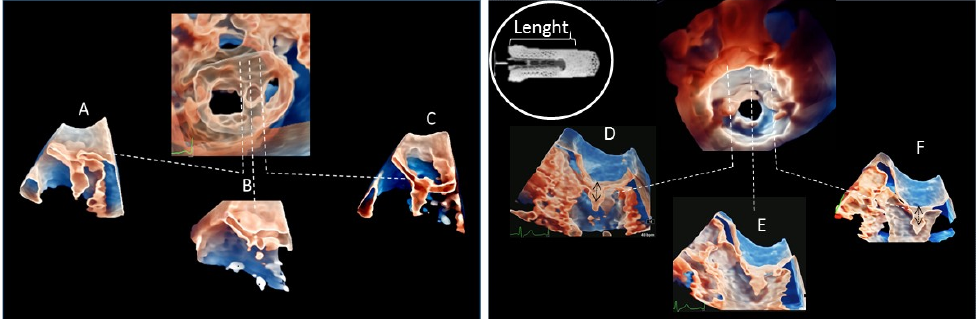
Figure 1. Left Panel: three-dimensional transesophageal (3DTEE) surgical view of a single MitraClip (MC) implantation with a typical optimal final result. From ( A – C ) consecutive longitudinal 3DTEE sections with transparency rendering from anterolateral to posteromedial. ( A ): visualization of the MC and the grasped anterior leaflet. ( B ): both leaflets are well visualized and the inserted leaflet portion may be measured. ( C ): MC depth is well defined. Right panel: 3DTEE reconstruction with transparency rendering of the mitral valve from left ventricular view in an atypical case with the insertion of 2 MC resulting in a single central orifice. From ( D – F ) consecutive longitudinal sections from anterolateral to posteromedial. ( D , F ) longitudinal sections of the 2 MC implanted in lateral ( D ) and medial ( F ) position, respectively. ( E ): longitudinal section of the central residual mitral orifice. White encircle panel: MC length that has been compared to the 3D images. Black arrows showing the MC length measurements corresponding with the nominal dimensions.